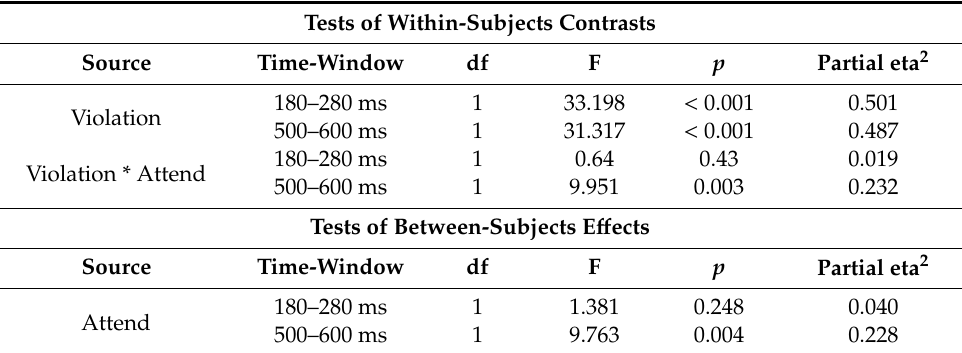
Figure 3. ERP e ff ects of violation (amplitude of di ff erence waves) across di ff erent conditions. Figure 3. ERP effects of violation (amplitude of difference waves) across different conditions. Table 2. ERP Table 2. ERP statistics.